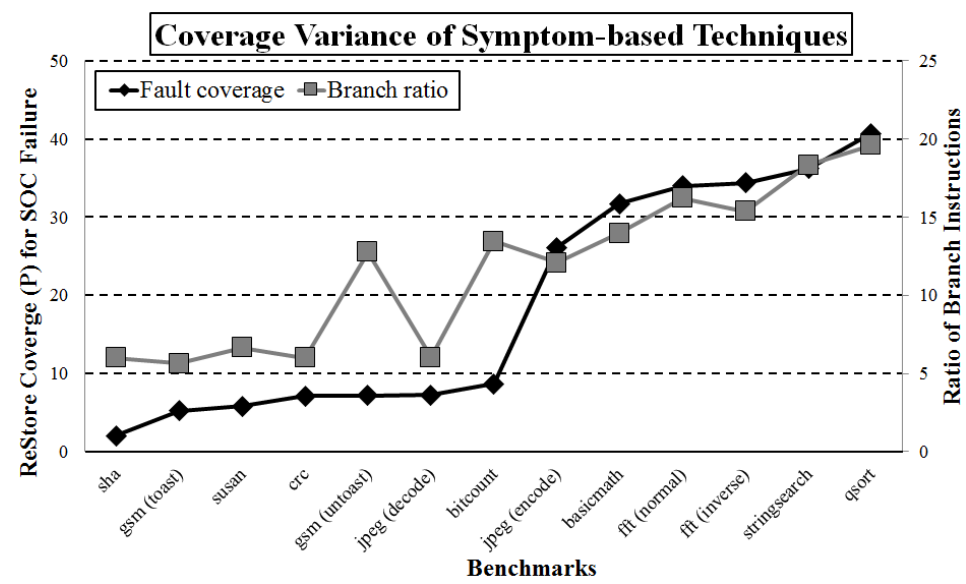
Figure 6. ReStore performs well for control-intensive programs, but is ineffective for data- intensive